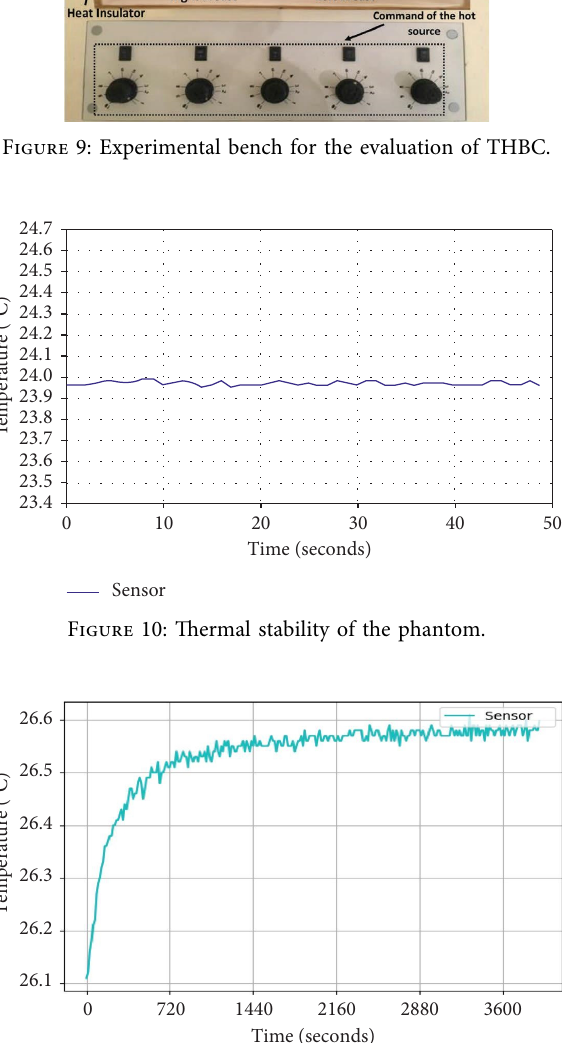
Figure 11: Temperature stabilization curve of the reference